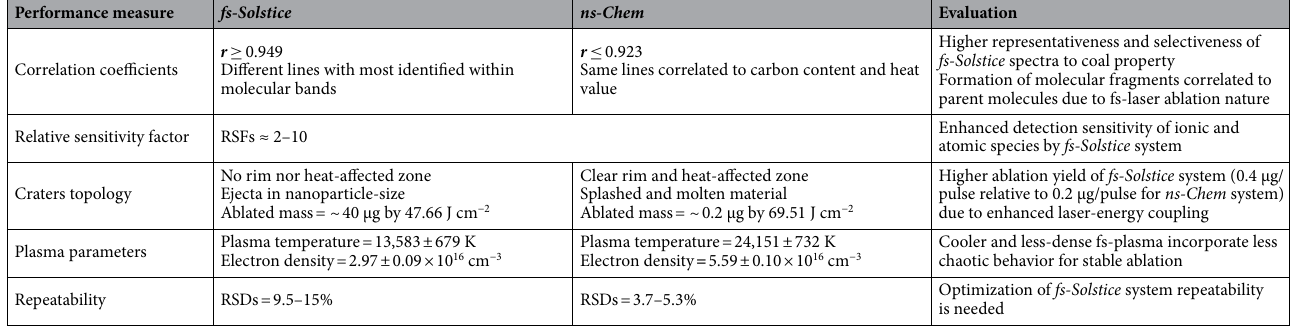
Table 7. Performance measures and evaluation results of fs-Solstice system relative to ns-Chem for coal